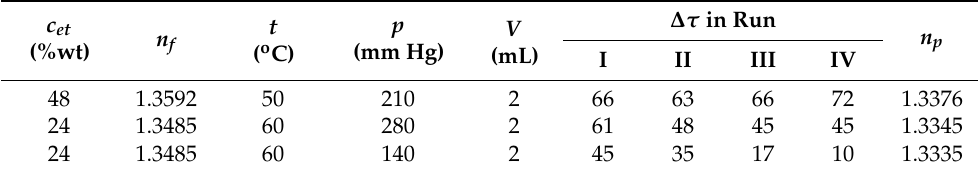
Table 1. Experimental data for PVA-BC 12/6 membrane